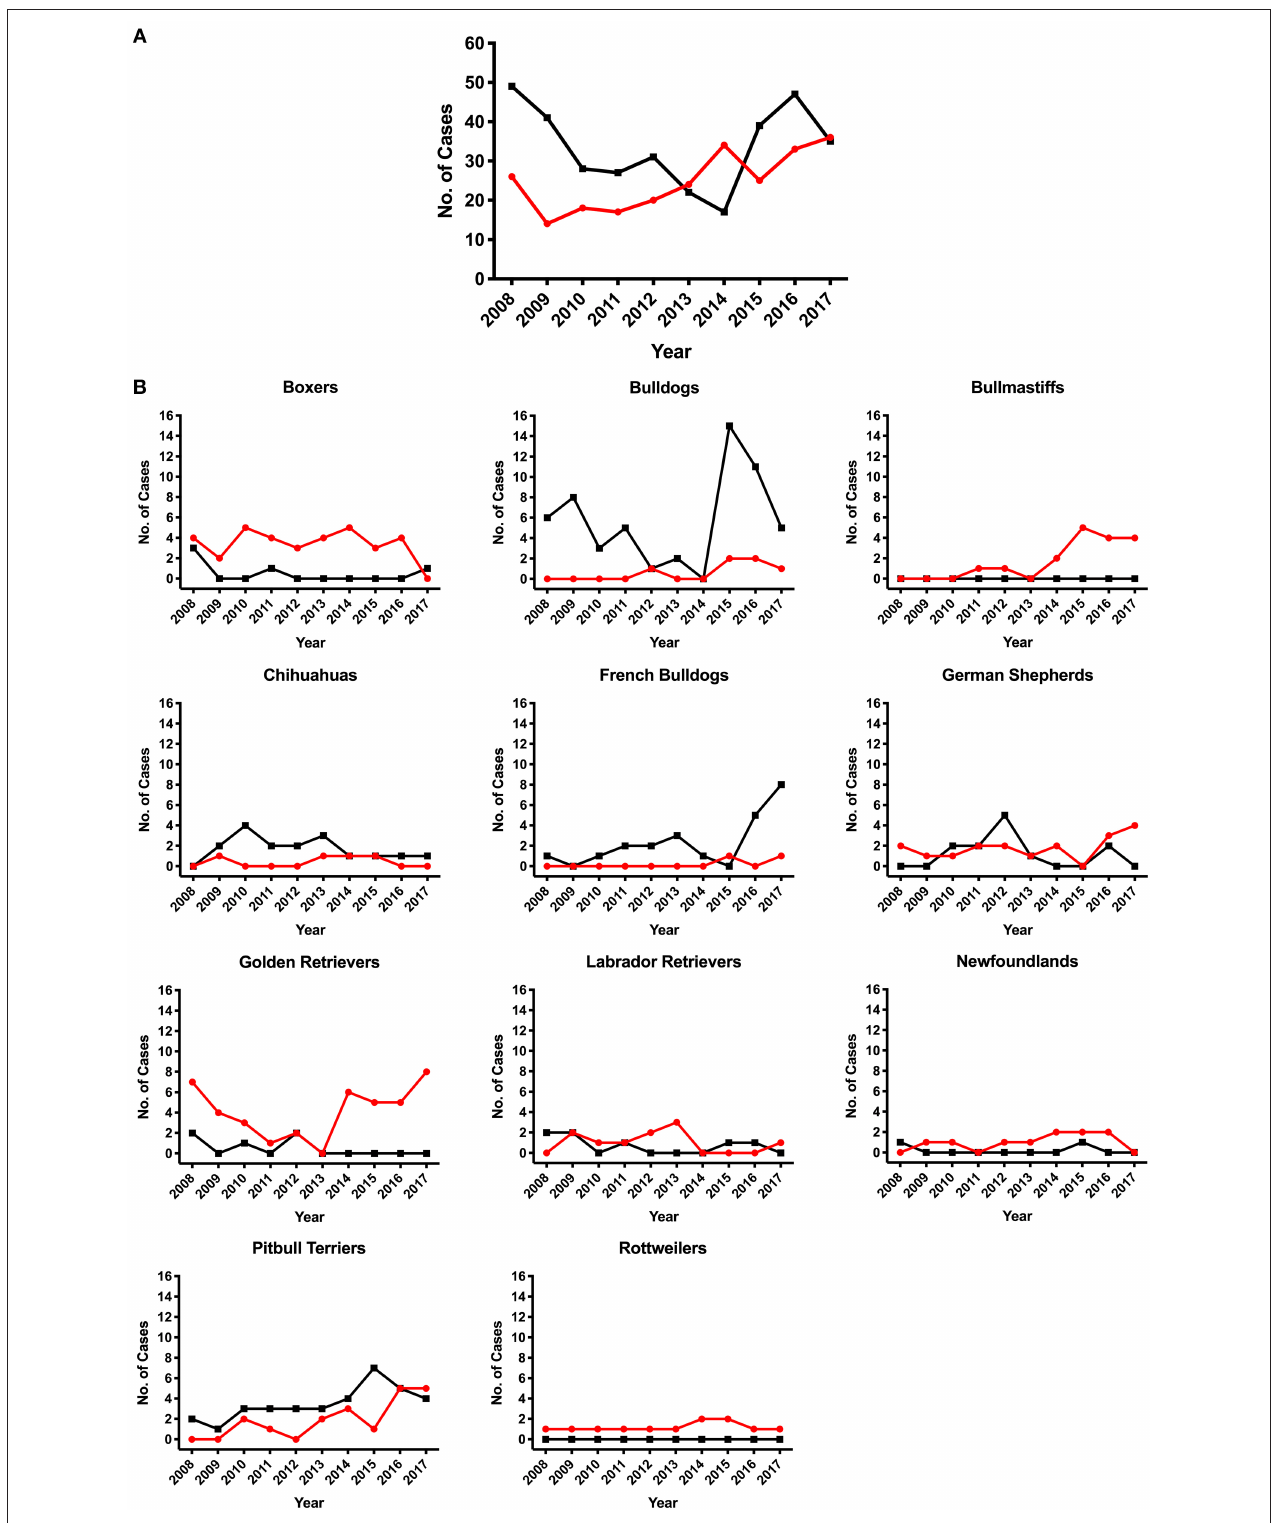
FIGURE 2 | Number of subvalvular aortic stenosis (SAS) or pulmonic stenosis (PS) cases diagnosed between January 2008 to December 2017. Dogs diagnosed with SAS or PS by the cardiology service team at a large university veterinary teaching hospital. (A) Overall number of dogs diagnosed with SAS (red line) or PS (black line). (B) Breeds that contained ≥ 10 cases of either disease during the study period. The red line illustrates SAS cases and black line illustrates PS cases.